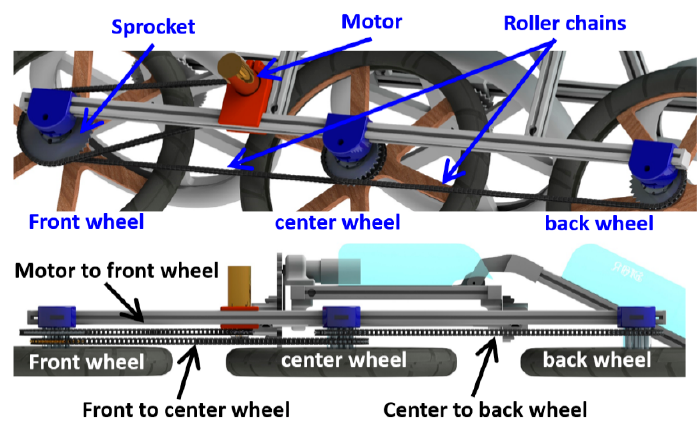
Figure 5. The gear transmission of the driving wheels.